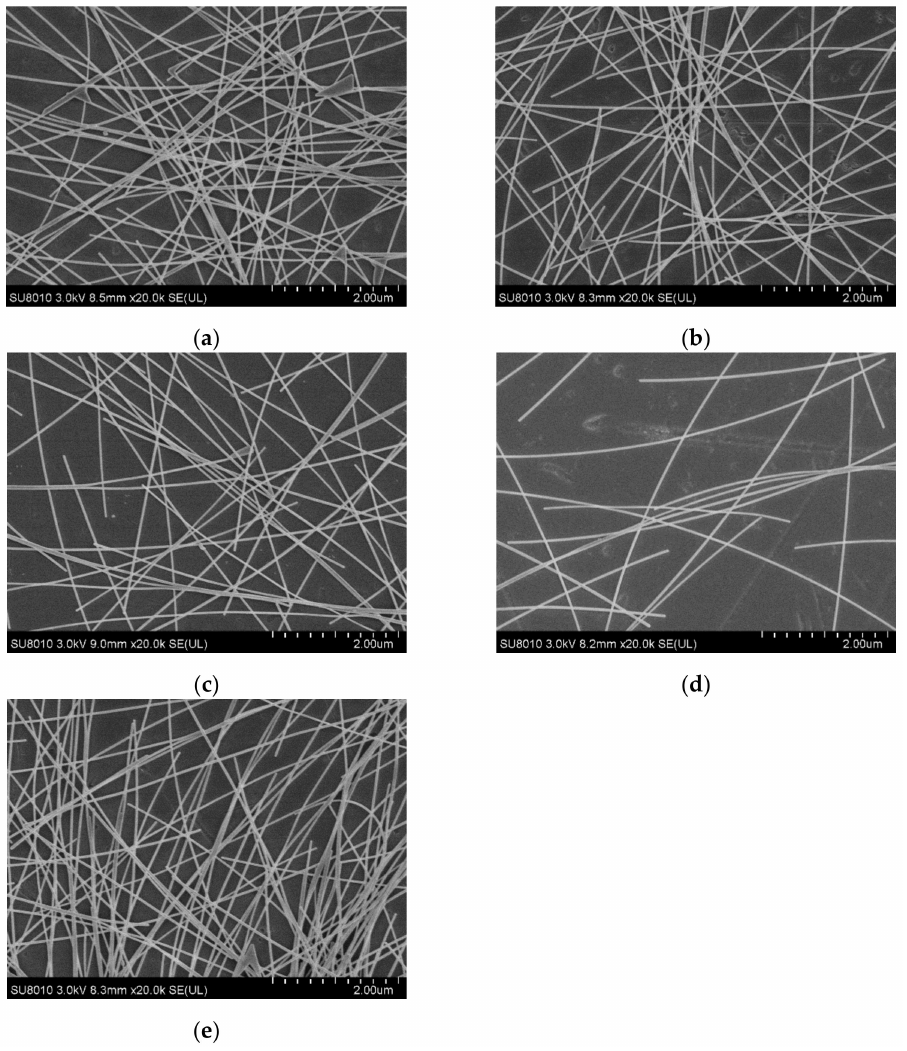
Figure 1. SEM morphology of AgNW transparent electrodes prepared at different concentrations and spin speeds: ( a ) 2 mg/mL and 1000 rpm; ( b ) 2 mg/mL and 2000 rpm; ( c ) 2 mg/mL and 3000 rpm; ( d ) 1 mg/mL and 2000 rpm; ( e ) 3 mg/mL and 2000 rpm,